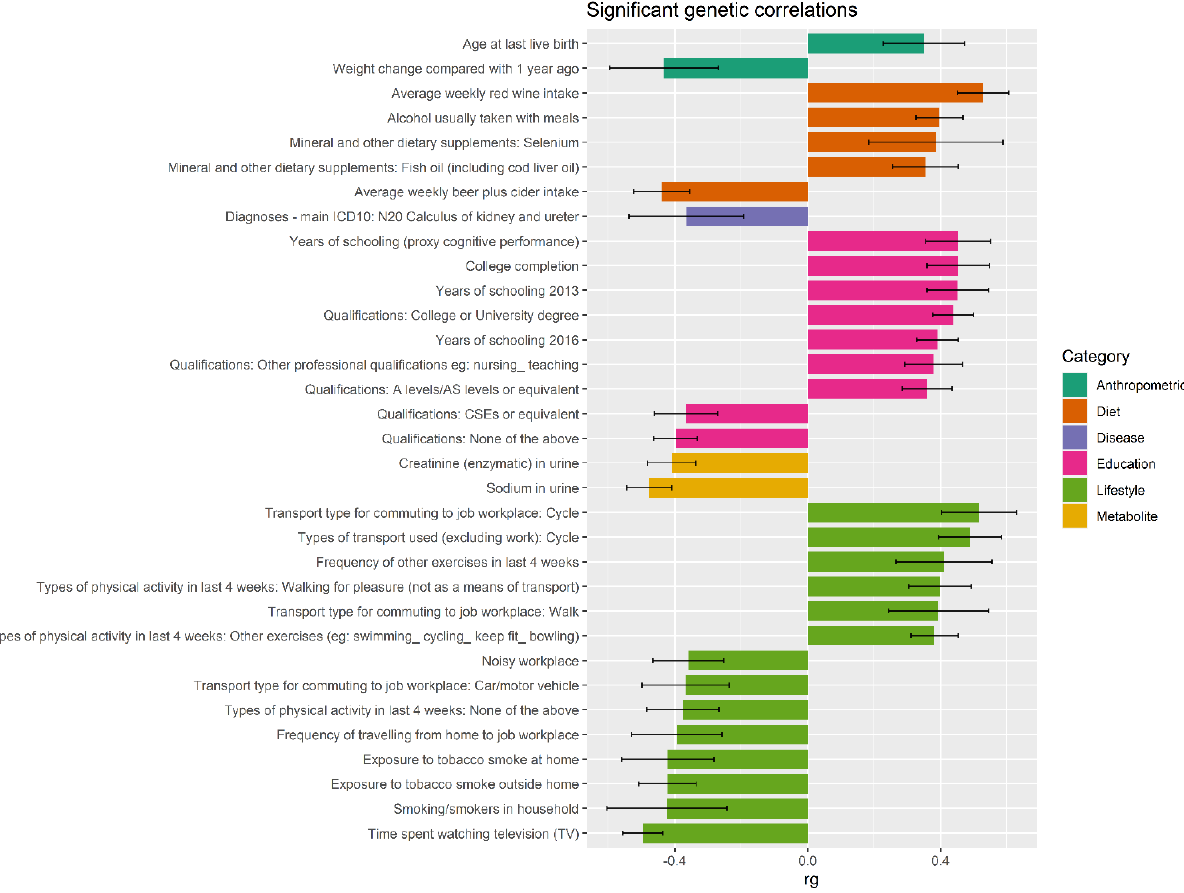
Figure 2. Genetic correlations (r g ). Pairwise genome-wide genetic correlations between DASH and 855 other phenotypic traits or diseases were estimated using LD score regression (LDSC). In the figure are represented only the strongest genetic correlations (r g < − 0.35 and r g > 0.35) (see ESI Supplementary Materials Table S7 for the report of the full results). Error bars show 95% confidence intervals, while colours represent the different categories. LD, linkage disequilibrium; ICD10, International Statistical Classification of Diseases and Related Health Problems 10th Revision; A, Advanced; AS, Advanced Subsidiar; CSE, Certificate of Secondary